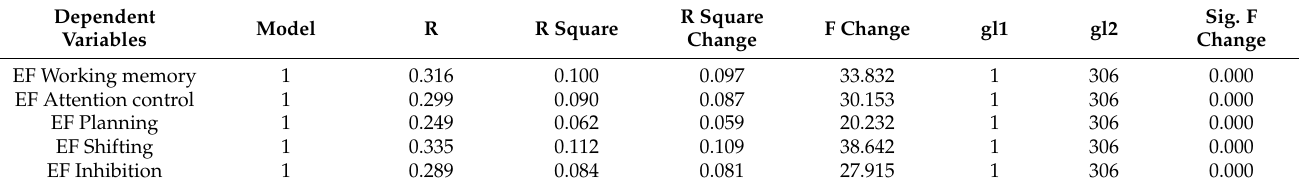
Table 14. Linear regression analysis relating specific antecedents and each component of